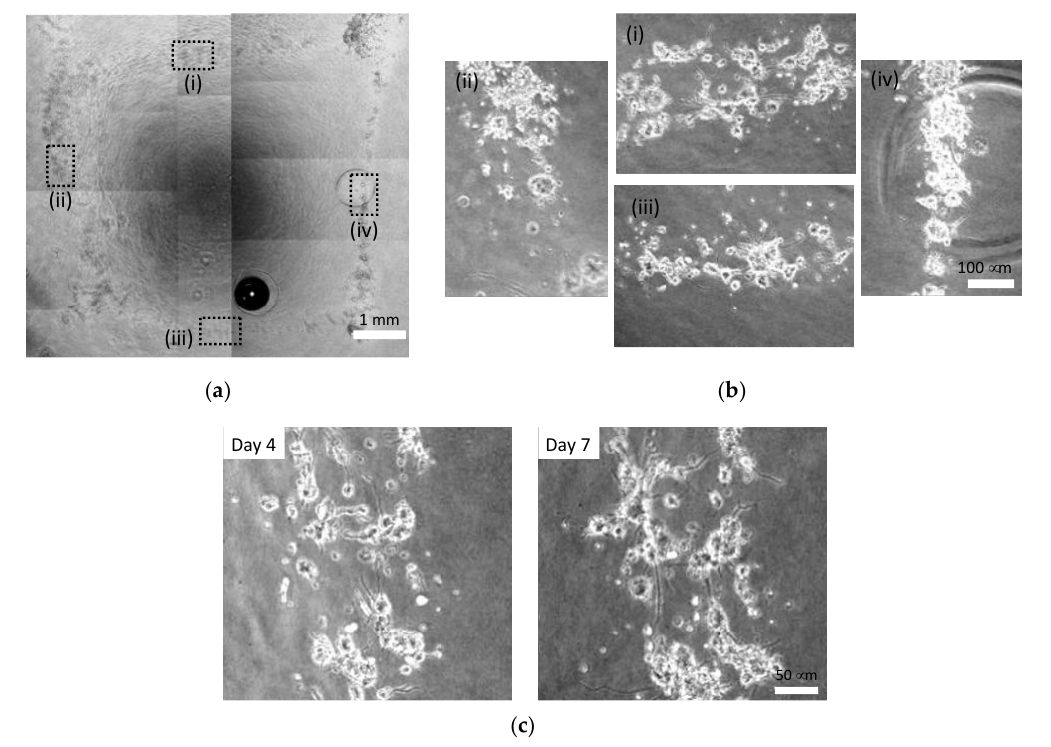
Figure 11. Phase-contrast images of square pattern of PC-12 cells injected at 0.480 mL/s in atelocolla- gen gel. ( a ) Gross image, ( b ) enlarged images of (i) Line 1, (ii) Line 2, (iii) Line 3 and (iv) Line4 of square pattern on day 7; ( c ) Neurite growth during the culture time.